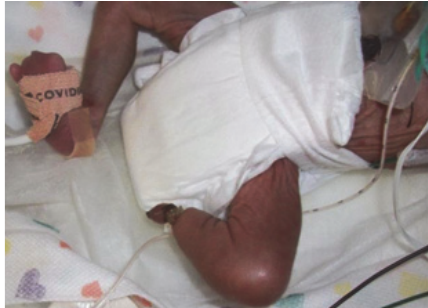
Figure 2: Left leg with amputation due to amniotic band. Right leg with only the 5th digit.